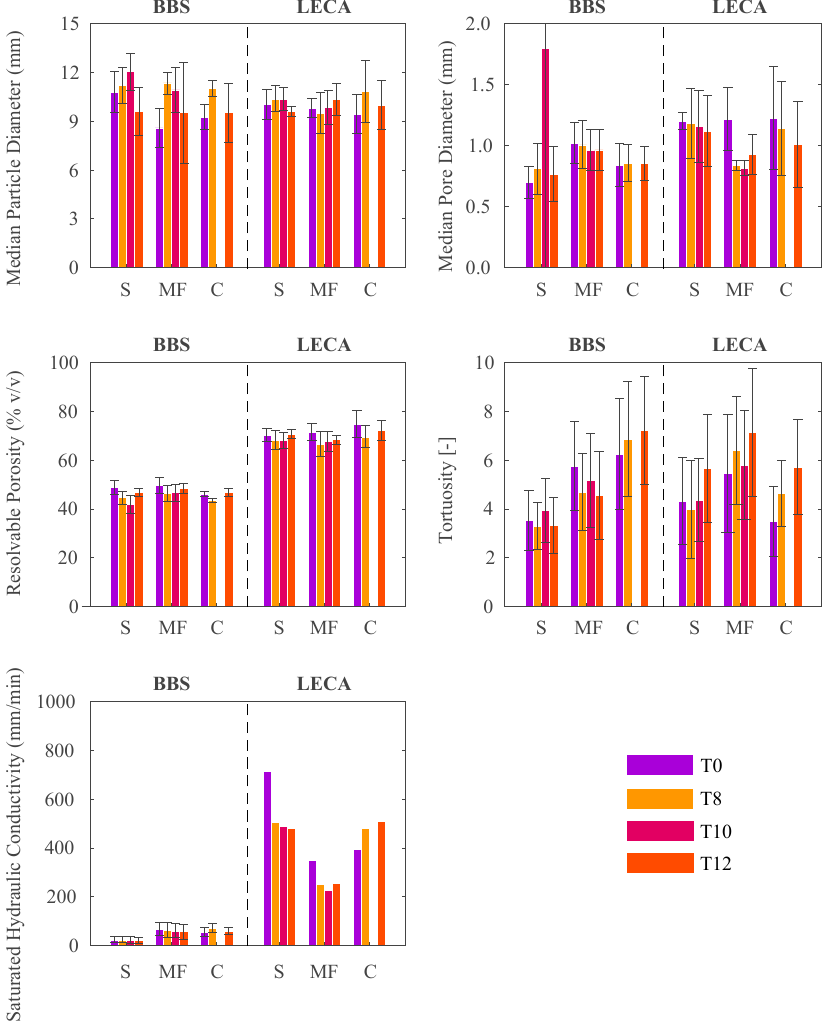
Figure 10. Comparison of XMT-derived properties over the course of the 12-month study period. Error bars indicate ±1 standard deviations. S —Sedum. MF —Meadow Flower. C —Control.